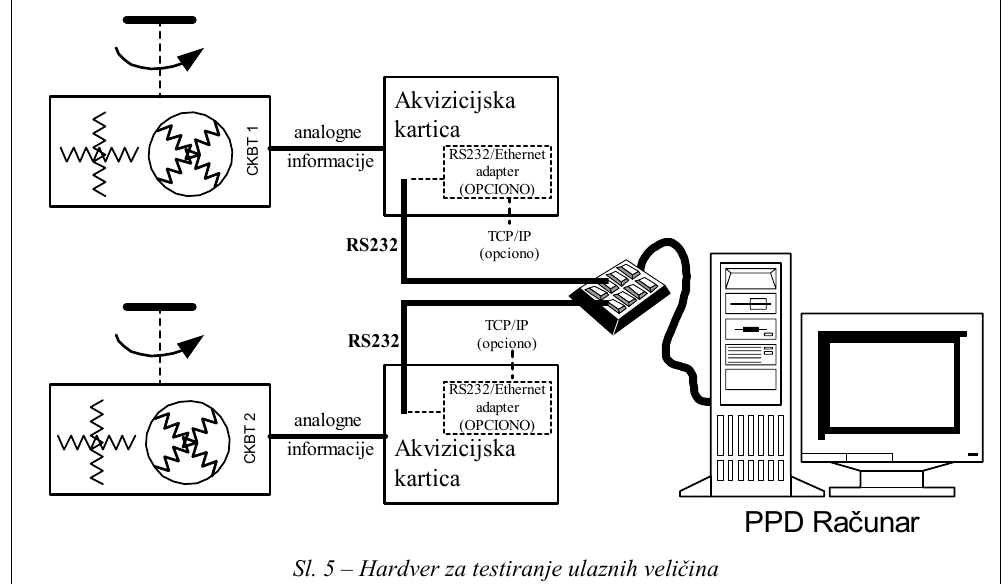
Sl. 5 – Hardver za testiranje ulaznih veli č